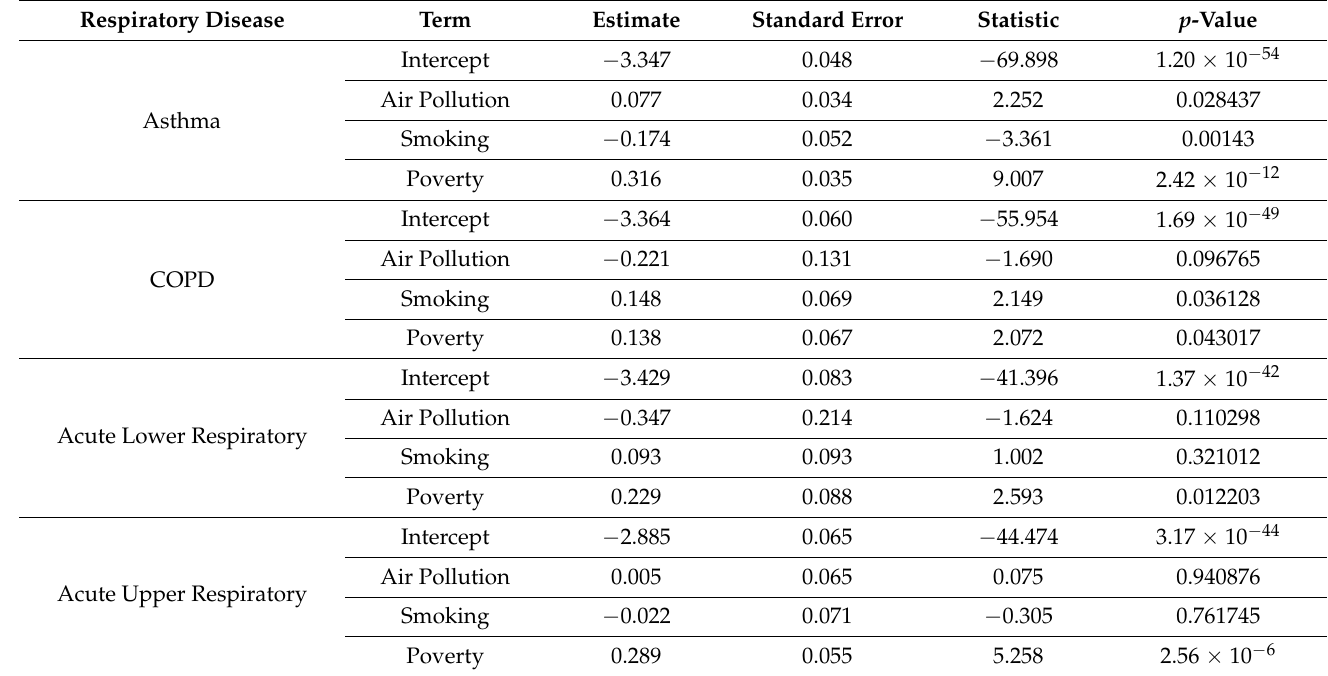
Table 5. The association between air pollution and respiratory diseases adjusted for smoking and poverty.